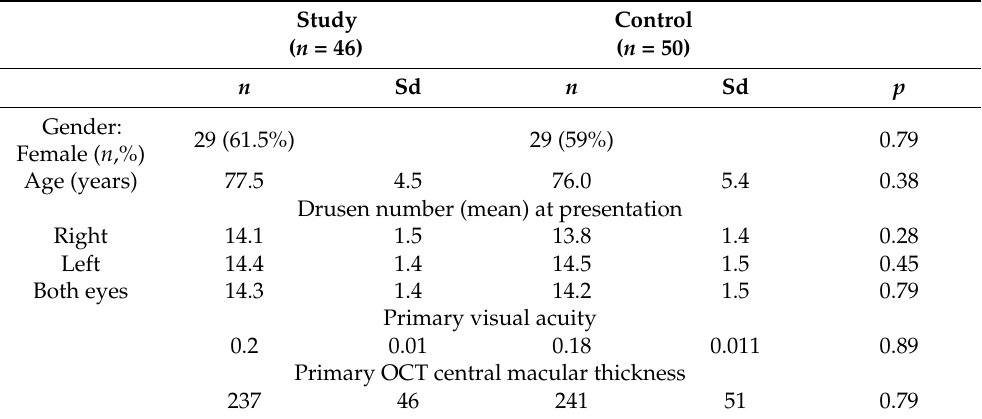
Table 1. Demographic characteristics and baseline ocular characteristics of the study (hydroxychloro- quine) and control (placebo)